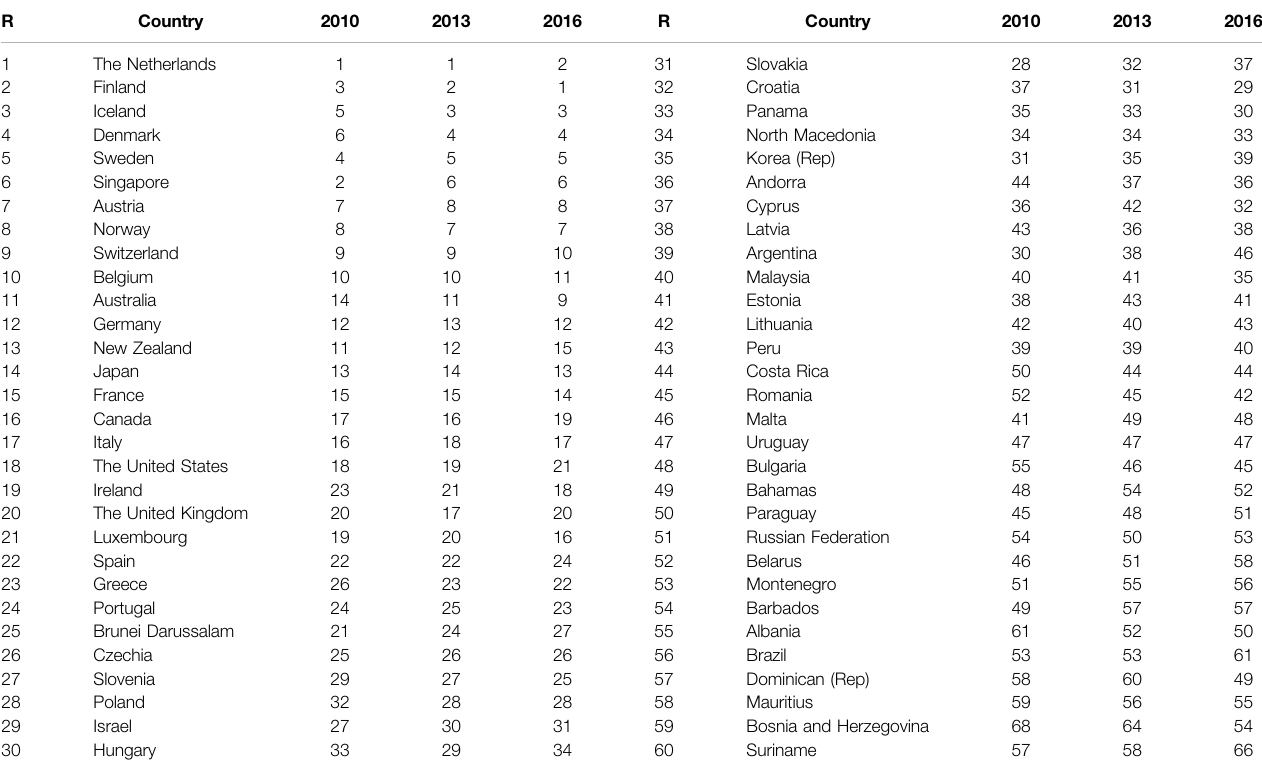
TABLE 4 | The rankings of High-NSDI